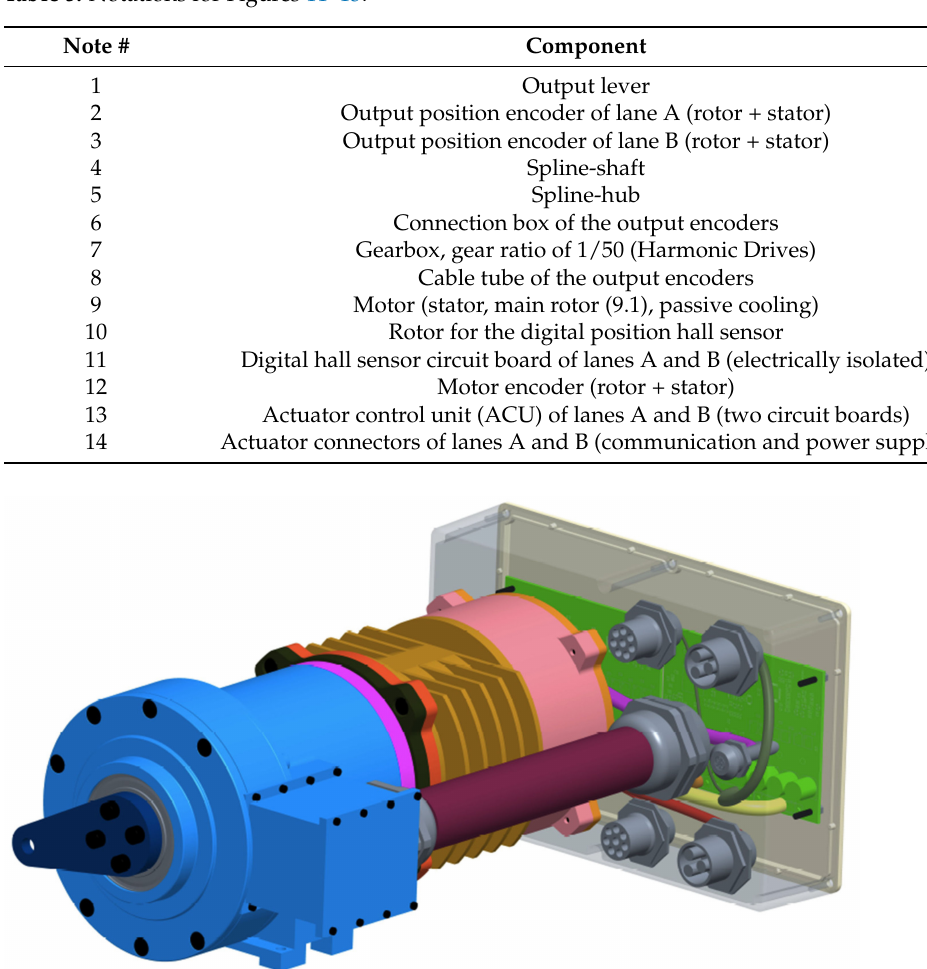
Table 5. Notations for Figures 11–13.